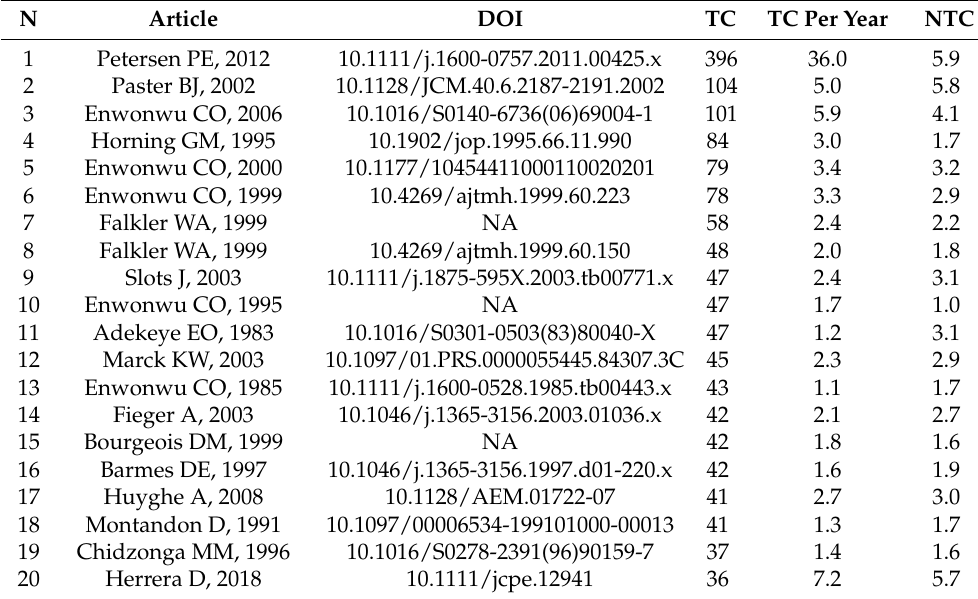
Table 1. Top 20 most cited articles on noma.